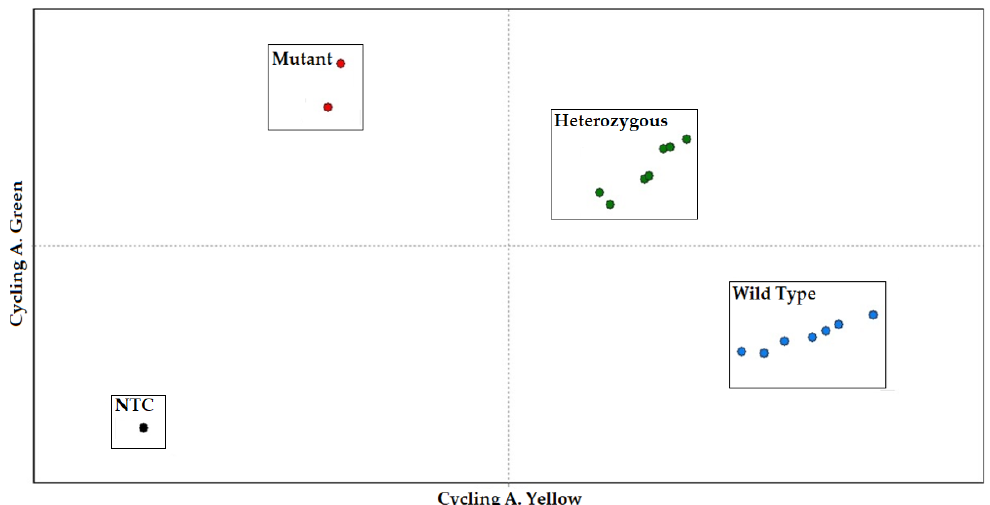
Figure 3. CSN2 genotyping with the multiplex TaqMan assay analyzed by scatter plot. The normal- ized fluorescence values of FAM (A1 mutant) versus HEX (A2 wild type) are shown.